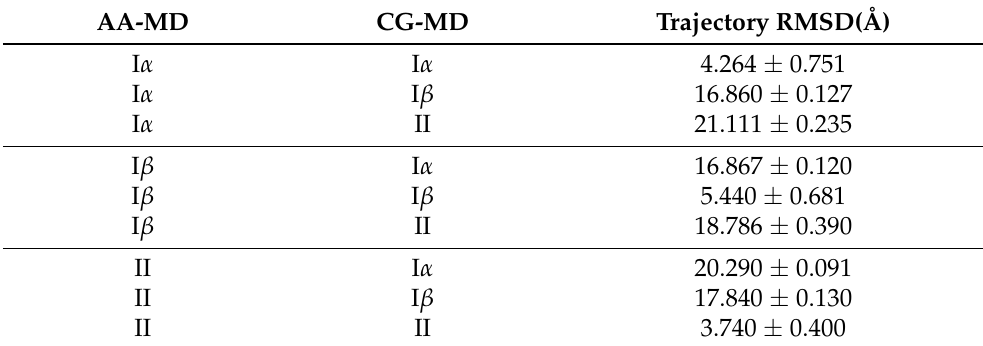
Table 4. RMSD cross-system for all cellulose fibril trajectories and their respective standard deviations. AA-MD